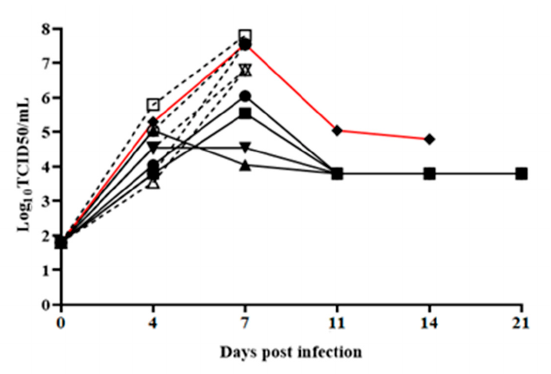
Figure 6. The virus titers in blood samples obtained from in animals IN infected with 10 5 TCID 50 of either E2 Δ SERTAD1v (filled symbols) or parental BICv (open symbols). Values are expressed as log 10 TCID 50 /mL. Sensitivity of virus detection: ≥ 10 1.8 TCID 50 /mL. In red is the evolution of viremia of the only E2 Δ SERTAD1v-infected animal euthanized at 14 dpi.